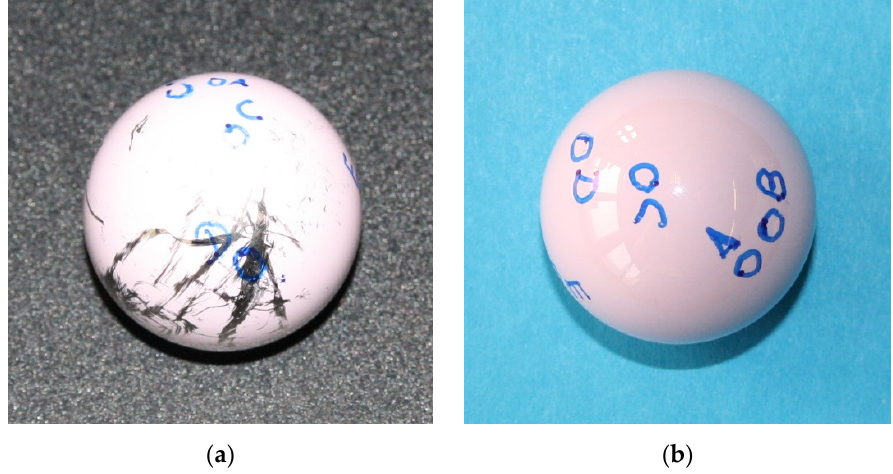
Figure 4. Picture of retrieved head before ( a ) and after ( b ) the cleaning and identification of zones.